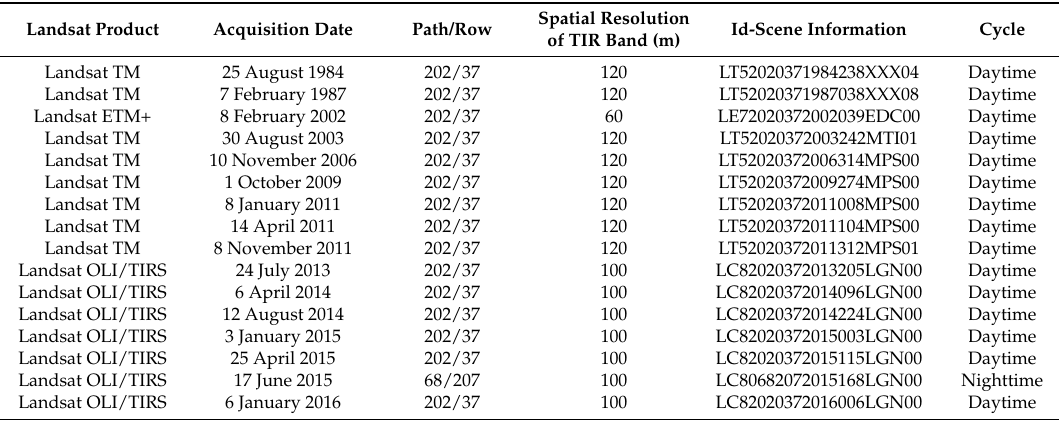
Table 1. Landsat TM/ETM+/OLI-TIRS imagery used in this